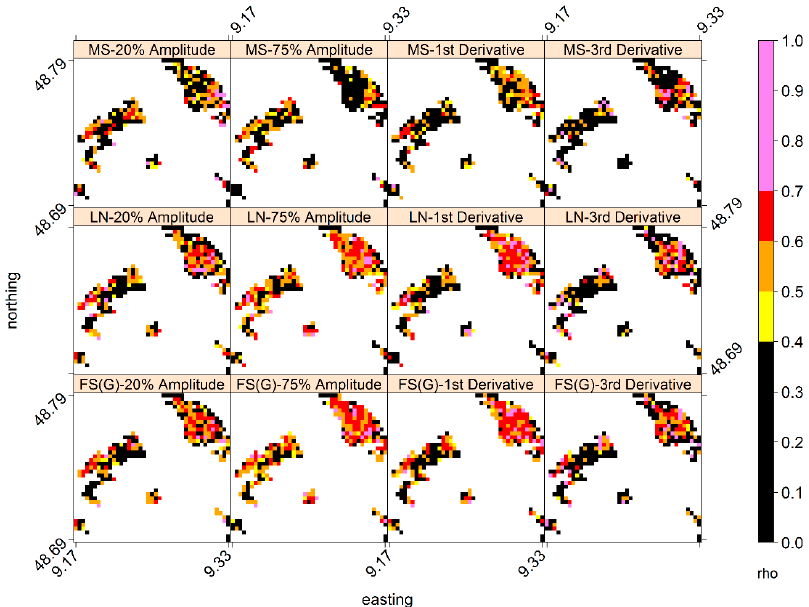
Figure 6. Maps showing Spearman’s rank correlations (p < 0.05, one-tailed positive) between LSP-SOS and GP-SOS for selected understory and broadleaf tree species. MS, Myosotis sylvatica (leaf unfolding); LN, Lathyrus niger (leaf unfolding); and FG(G), Fagus sylvatica (greening), with mean SOS of 70.5, 102.7 and 120.9 day of year, and species ID/No. 12, 95 and 119, respectively. Note: The mean correlations of each species GP-SOS over the study area are shown in Figure S2 in supplement. Refer to Table S1 for details of GP-SOS.